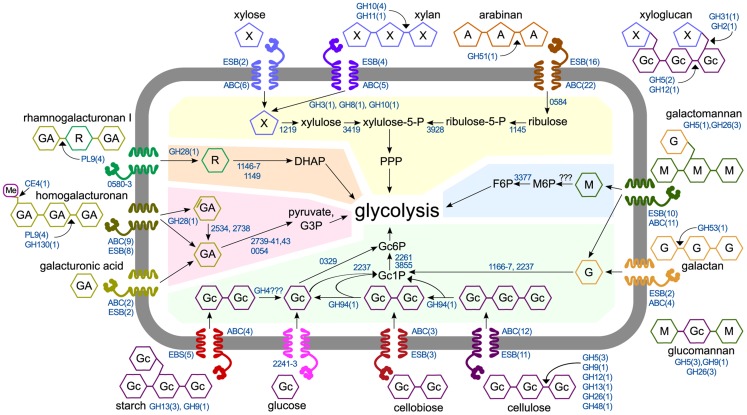
Model of polysaccharide degradation and metabolism by C. phytofermentans. CAZymes (shown as the number of enzymes in CAZy families) are based on purified activities and are intra- or extracellular based on putative secretion signals.Metabolic enzymes are shown as NCBI numbers and are proposed based on mRNA expression. Rhamnose transport and assimilation is based on pathway from [55]. Abbreviations are D-galacturonic acid (GA), L-rhamnose (R), D-mannose (M), D-glucose (Gc), D-galactose (G), D-xylose (X), L-arabinose (A), fructose (F), phosphate (P), pentose phosphate pathway (PPP), dihydroxyacetone-phosphate (DHAP), glyceraldehyde-3-phosphate (G3P). For each substrate, the number of significantly up-regulated extracellular solute binding proteins (ESB) and ABC transporters (ABC) are shown. Shaded regions show metabolism of glucose (green), mannose (blue), xylose and arabinose (yellow), rhamnose (orange), and galacturonic acid (red).